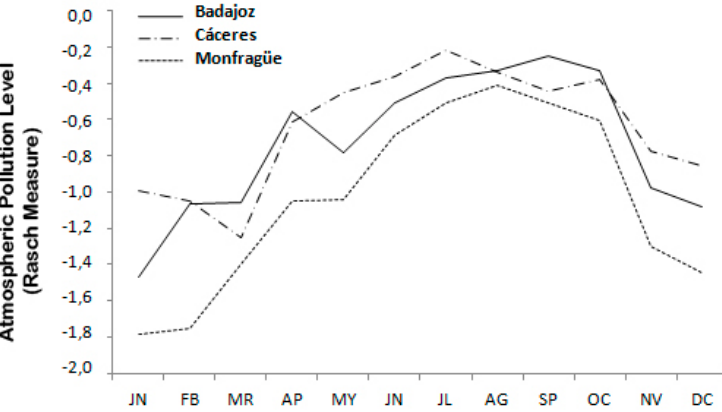
Figure 4. Temporal evolution of atmospheric pollution levels at the two urban (Badajoz and Cáceres) and the one rural (Monfragüe) locations, in 2016.